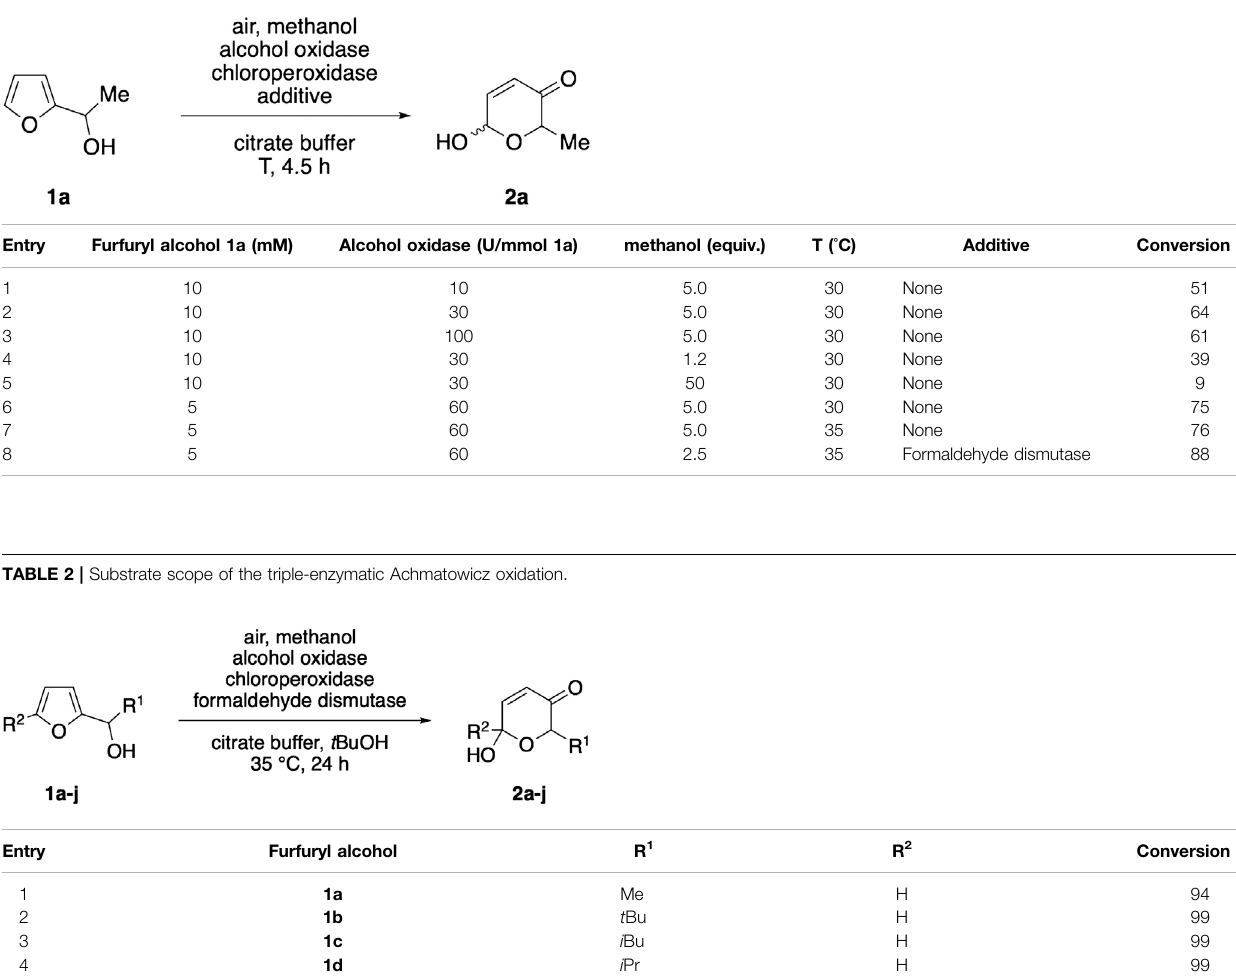
Entry Furfuryl alcohol R 1